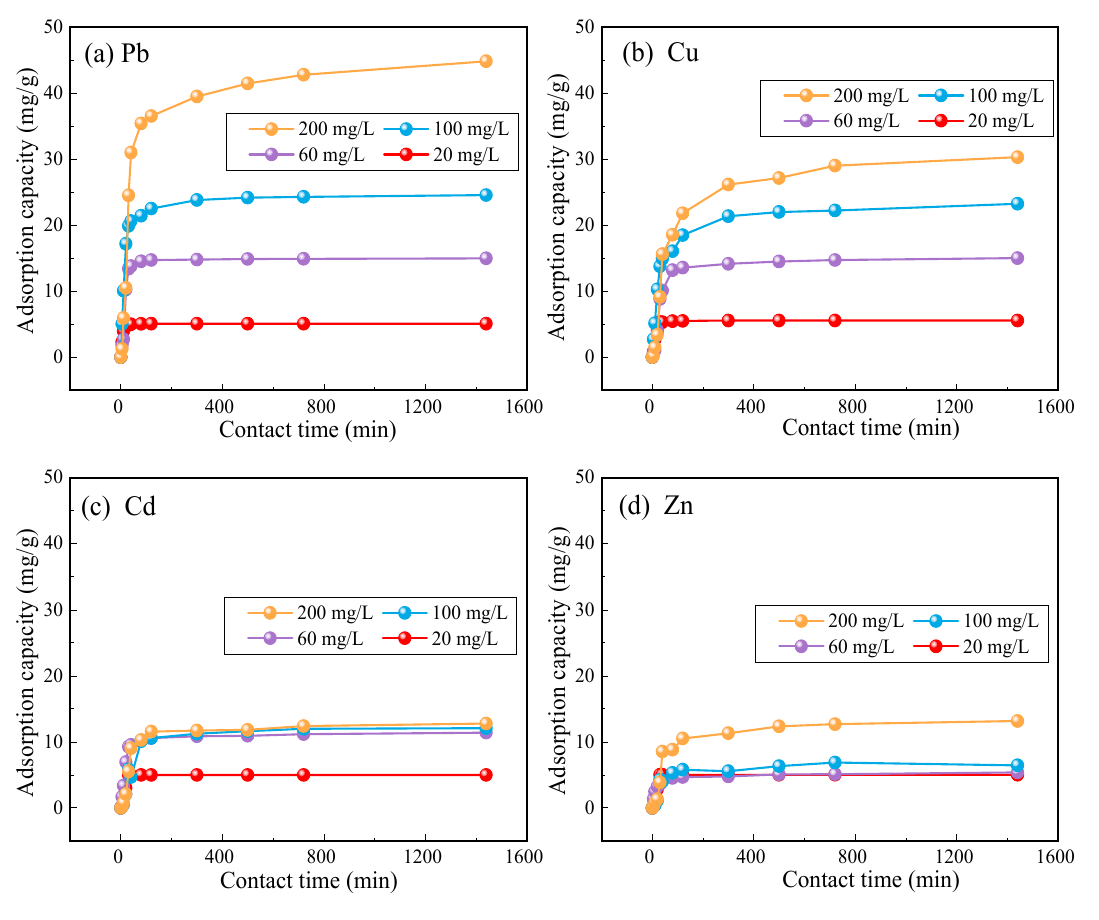
Figure 5. Effect of initial metal ions concentration on the adsorption capacity of ( a ) Pb(II), ( b ) Cu(II), ( c ) Cd(II) and ( d ) Zn(II) onto the WAC-resin (liquid–solid ratio = 250 mL/g, room temperature, pH = 4 and time = 12 h).